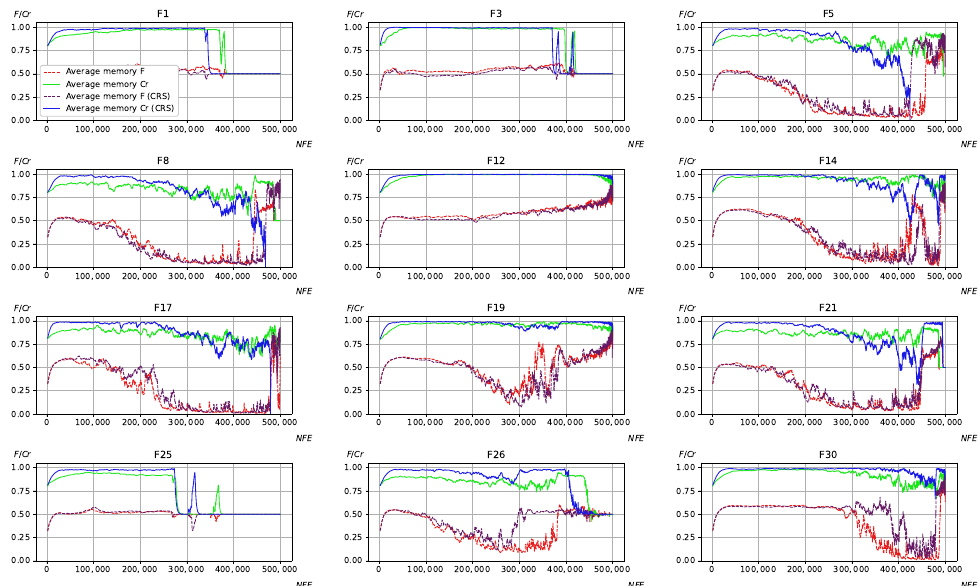
Figure 3. Parameter adaptation with and without crossover rate sorting, L-SHADE-RSP, CEC 2017, 50 ∗ D .